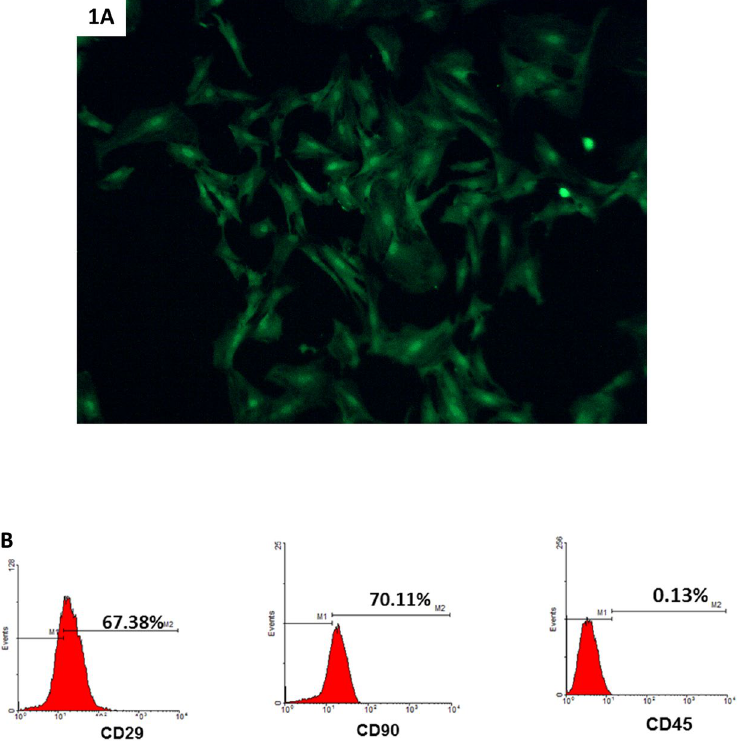
Figure 1. MSC phenotype and characterization in culture. An image of GFP-MSCs in culture showed a spindle-shaped morphology ( 1A ), phase-contrast microscopy, x100). Flow cytometric analysis of MSCs using phycoerythrin-conjugated anti-CD29, anti-CD90 and anti-CD45 ( 1B